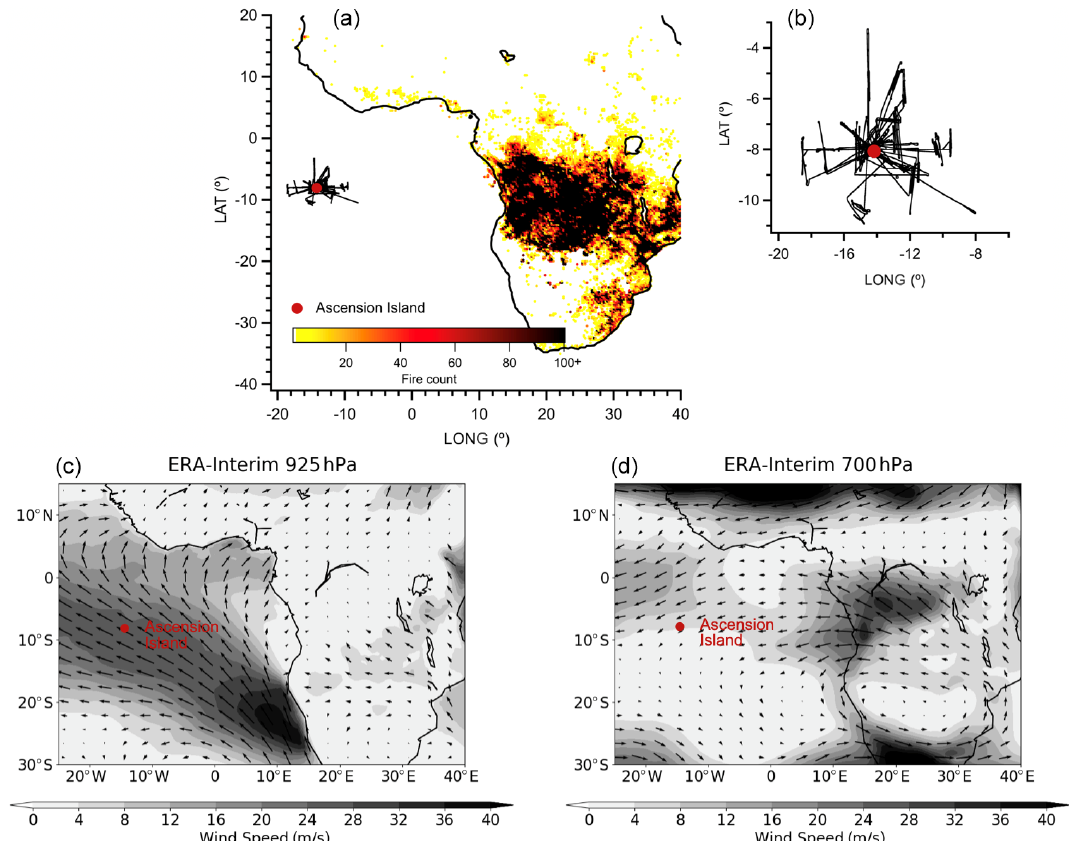
Figure 1. (a, b) The integrated spatial distribution of MODIS-detected fire counts in August 2017, coupled with flight tracks (without transit flights) during the CLARIFY-2017 aircraft campaign (16 August–7 September). (c, d) Average wind speed and direction at 925hPa (c) and 700hPa (d) in ERA-Interim reanalysis for August 2017. The wind speed is shown in greyscale